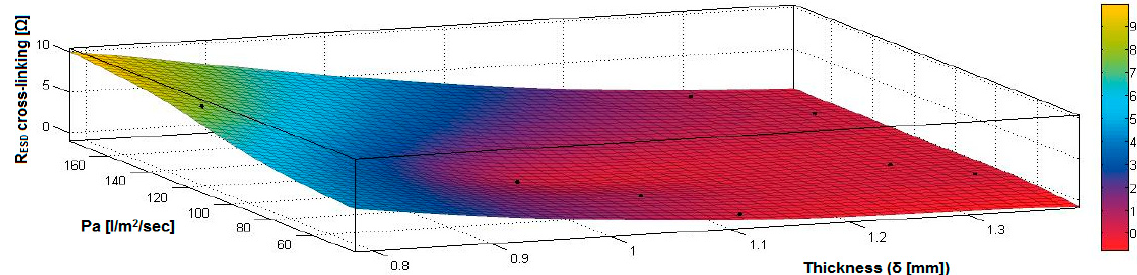
Figure 26. 3D representation R ESD after crosslinking = f(M, δ ) samples preliminarily treated in RF plasma O 2 using RF 1 generator and power 200 W.